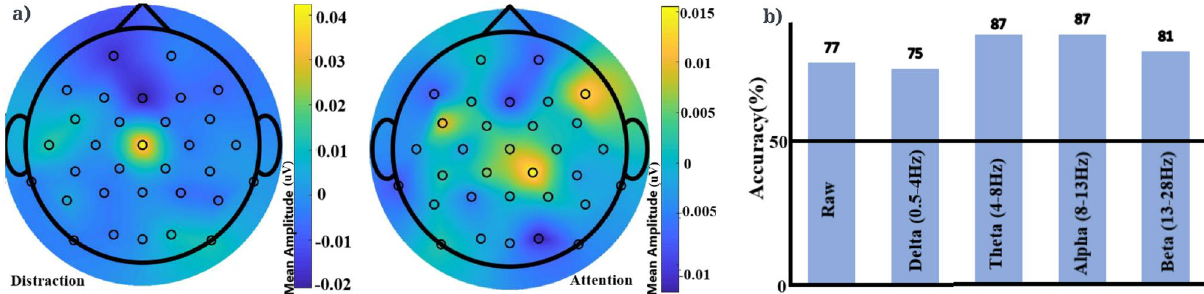
Figure 6. a) Topography maps of mean amplitudes (µV) corresponding to distraction state (left) and attention state (right) in alpha wave for dataset ’B’. b) Classification accuracy on the basis of different data aspects for the dataset ’B’ using the random forest